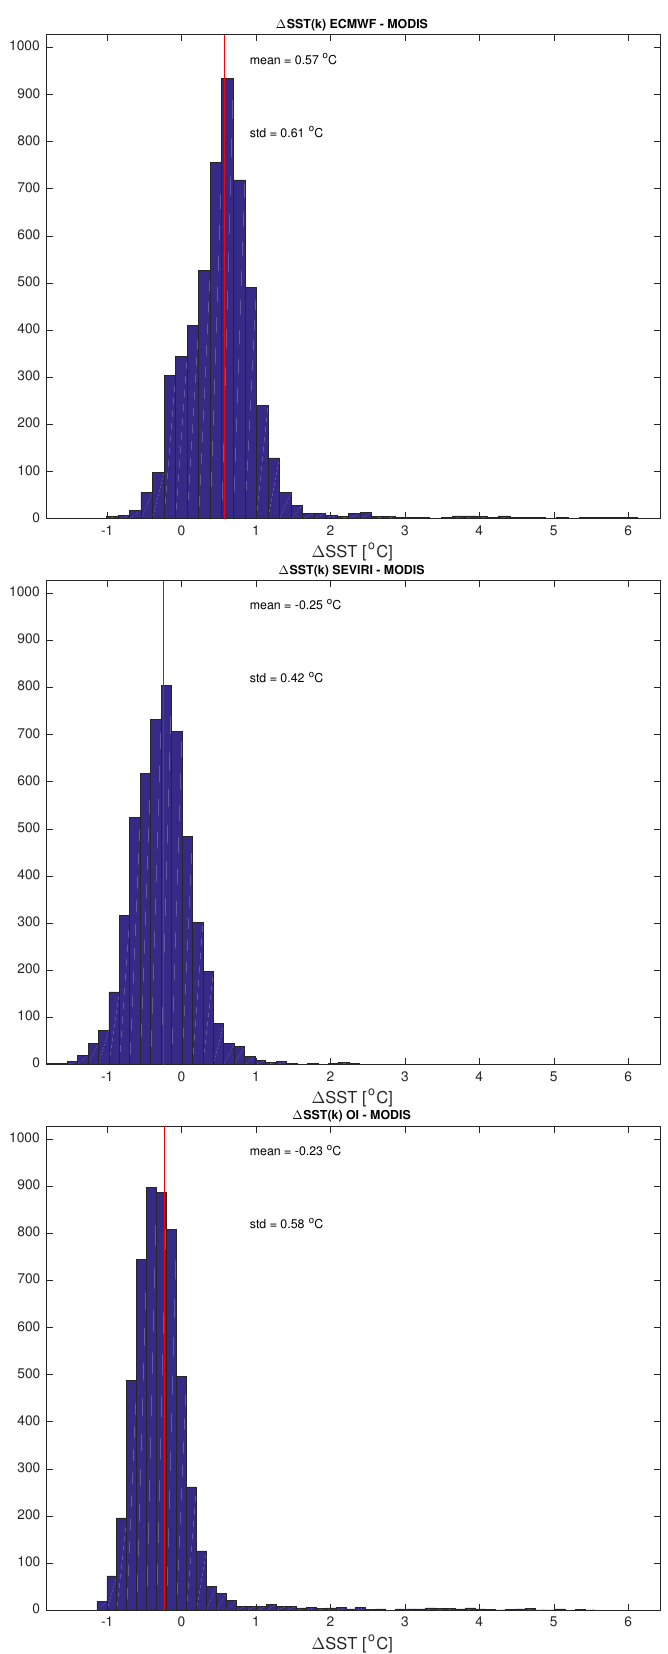
Figure 10. Histogram of the SST differences between ECMWF background and MODIS, L2 SEVIRI and MODIS, OI and MODIS for the 11 August